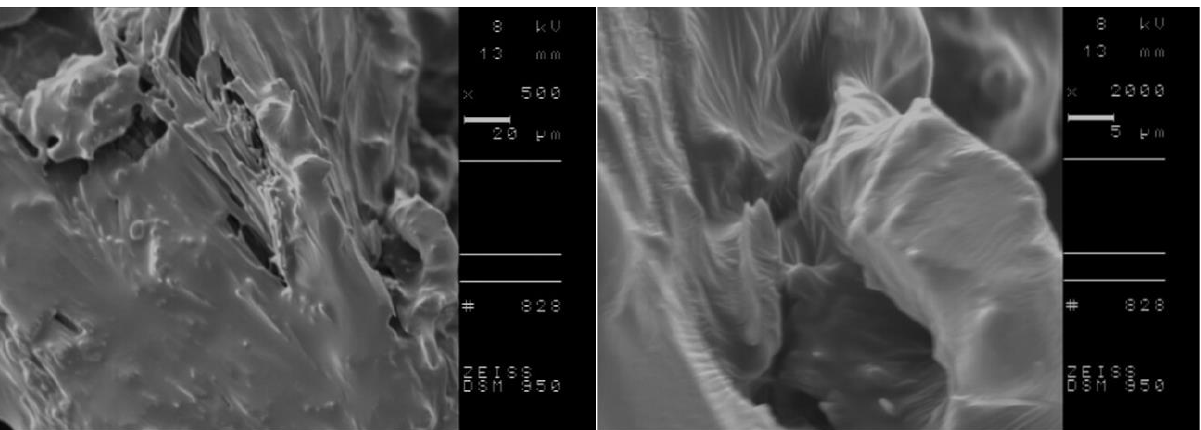
Figure 6. The SEM micrographs of [L-IleOiPr][IBU]; in the top row: before the conditioning step and in the bottom row: after the conditioning step; on the right: enlarged 2000 times SEM image; on the left side lower magnification (enlarged 320 and 500 times respectively).